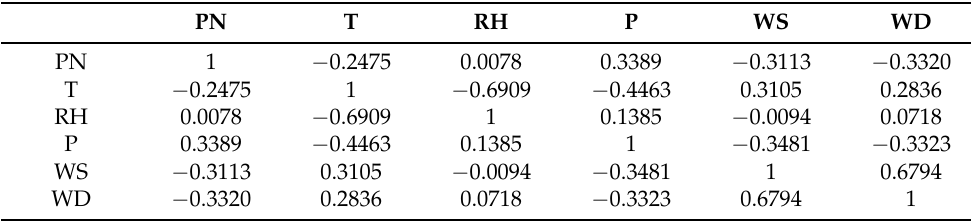
Table 2. Pearson’s coefficient between